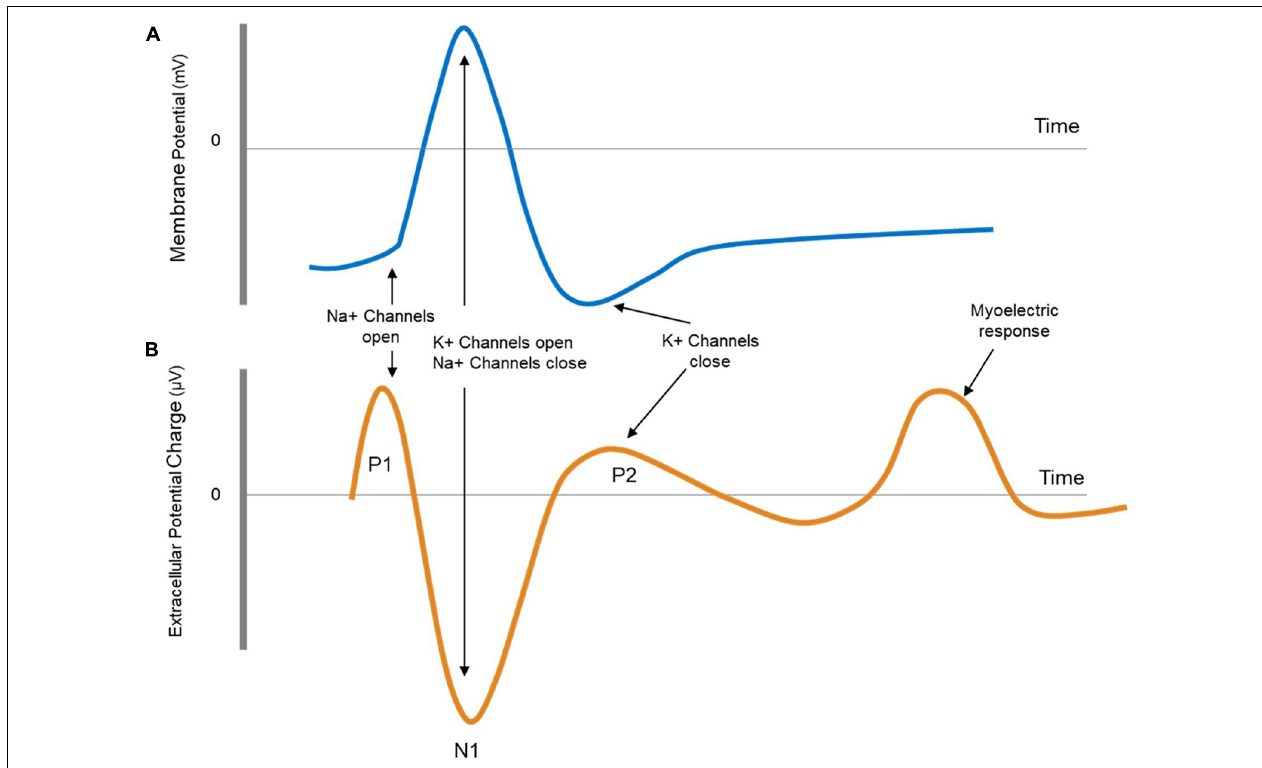
FIGURE 2 | (A) Schematic representation of an action potential as measured intracellularly. (B) Schematic representation of an evoked compound action potential (ECAP) followed by a myoelectric response. The ECAP is measured extracellularly and is therefore opposite in sign and smaller ( µ V) compared to the intracellular action potential. The shape of myoelectric response can take a number of forms (multiple phases, varying polarities).